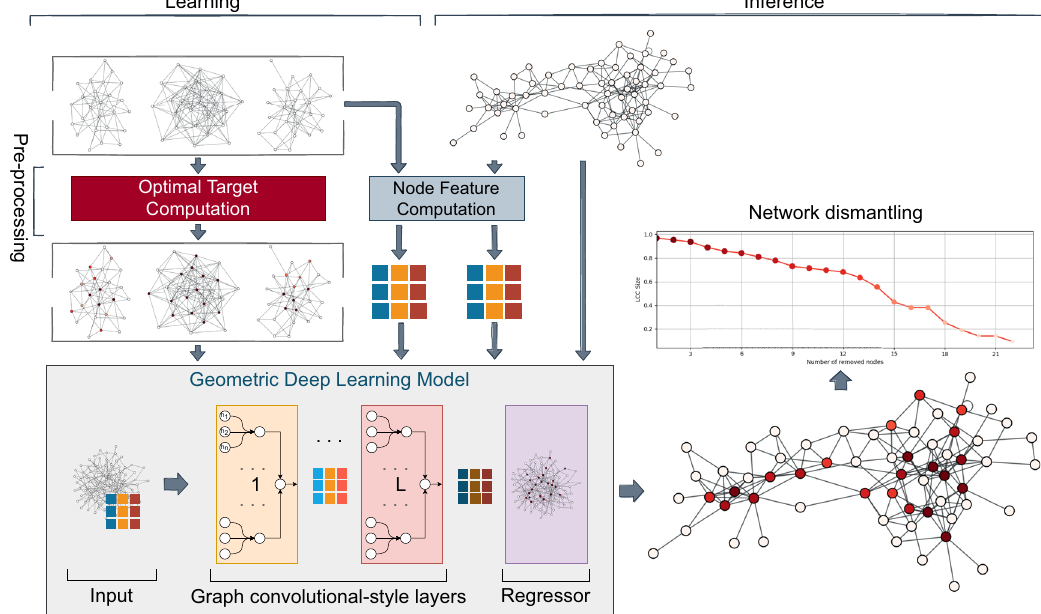
Fig. 1 Training a machine to learn complex topological patterns for network dismantling. To build our training data, we generate and dismantle small networks optimally and compute the node features. After the model is trained, it can be fed the target network (again, with its nodes' features) and it will assign each node n a value p n , the probability that it belongs to the (sub-)optimal dismantling set. Nodes are then ranked and removed until the dismantling target is reached. The machine learning architecture used consists of graph convolutional-style layers (Graph Attention Network (GAT) layers) coupled with linear layers — that provide residual connections between consecutive layers — followed by a regressor (i.e., a Multilayer Perceptron) with a sigmoid activation function that constrains the p n value to the [0, 1]